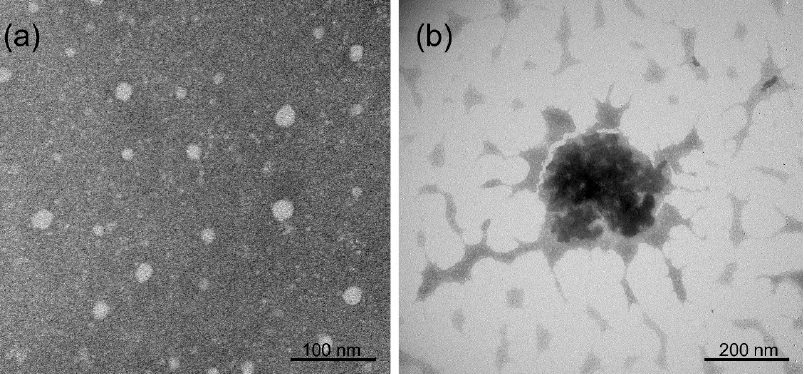
Figure 2. TEM images of aqueous 10% (w/v) SBE β CD solutions saturated with VCZ with and with- out PVA ( a ) VCZ/SBE β CD and ( b ) VCZ/SBE β CD/PVA.